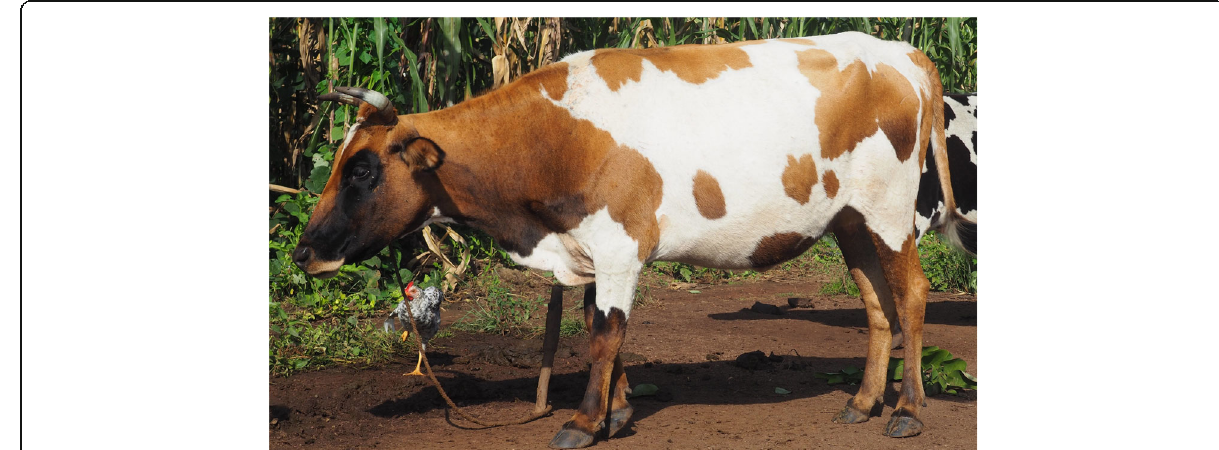
Fig. 1 Photo of Somba cattle